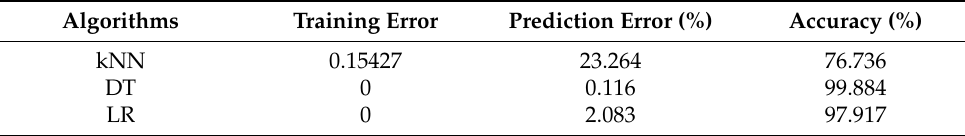
Table 8. Training and prediction results accuracy for application case 1.